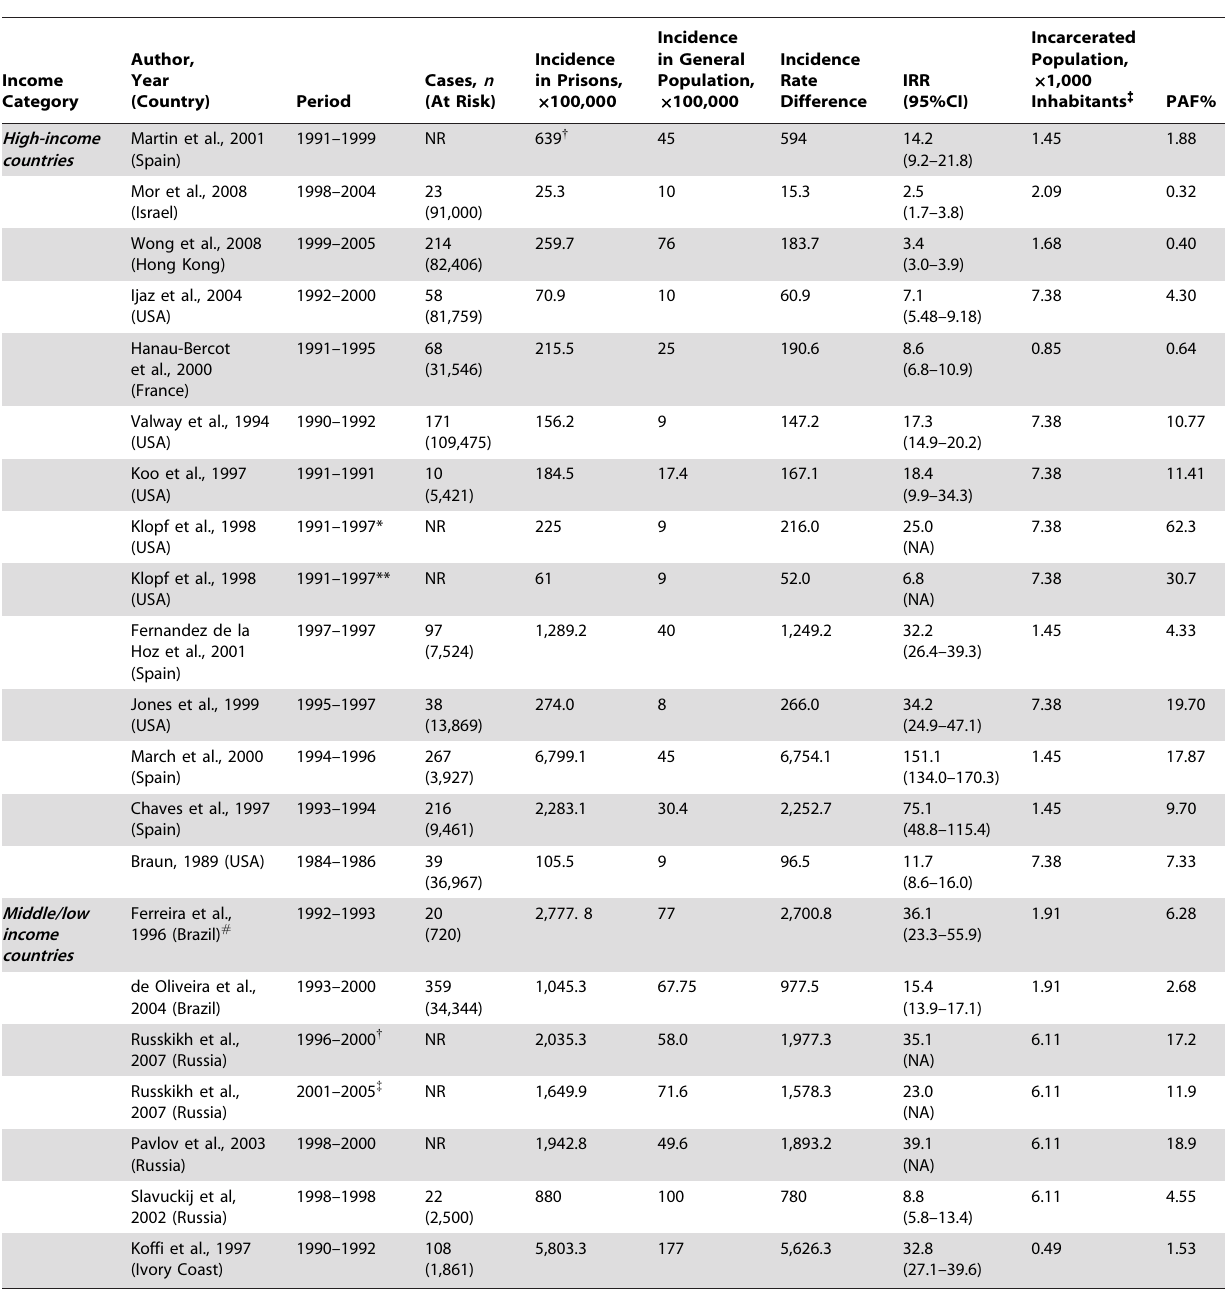
Table 2. Studies reporting TB incidence in prisons, by income area according to the World Bank classification.